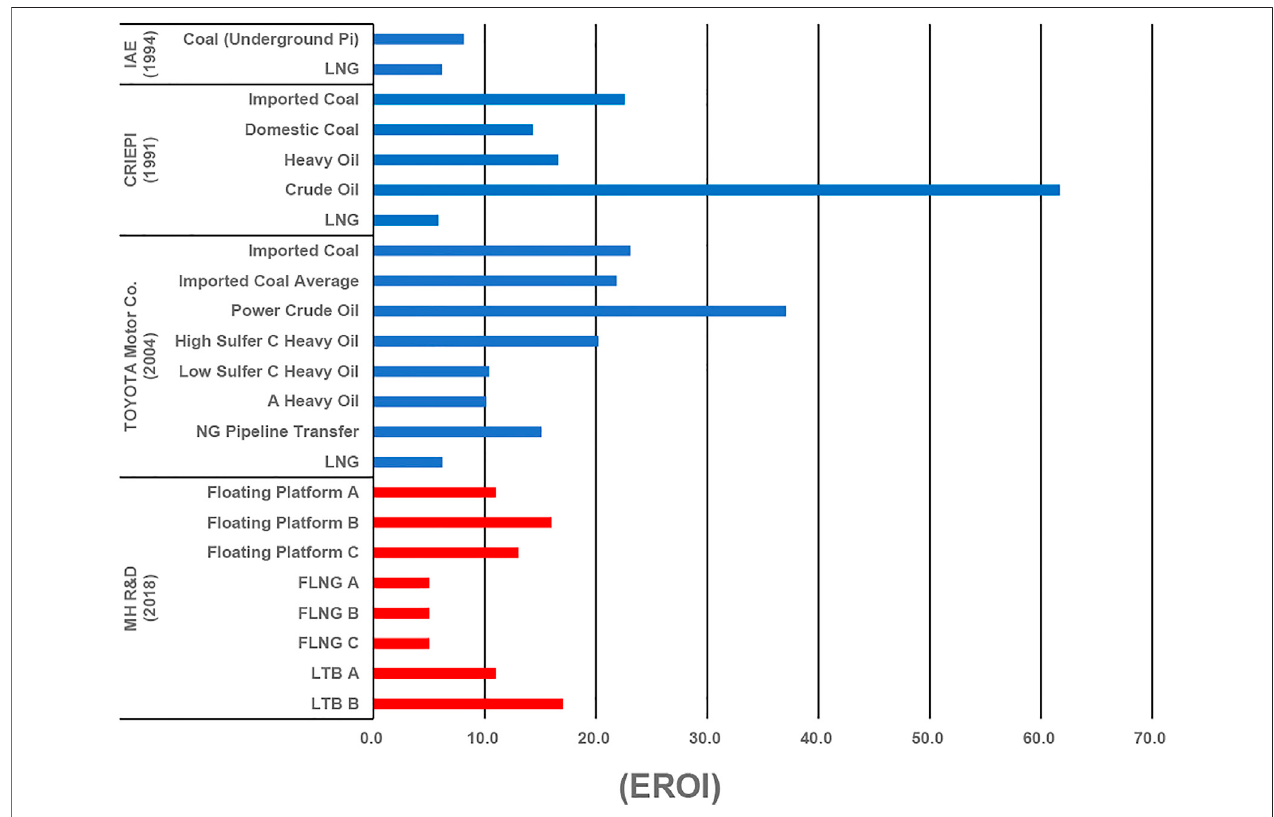
FIGURE 9 | Energy return on investment of each energy source consumed in Japan. Toyota Motor Corporation and Mizuho Information and Research Institute, Inc., 2004, Central Research Institute of Electric Power Industry (1991), The Institute of Applied Energy (1994).